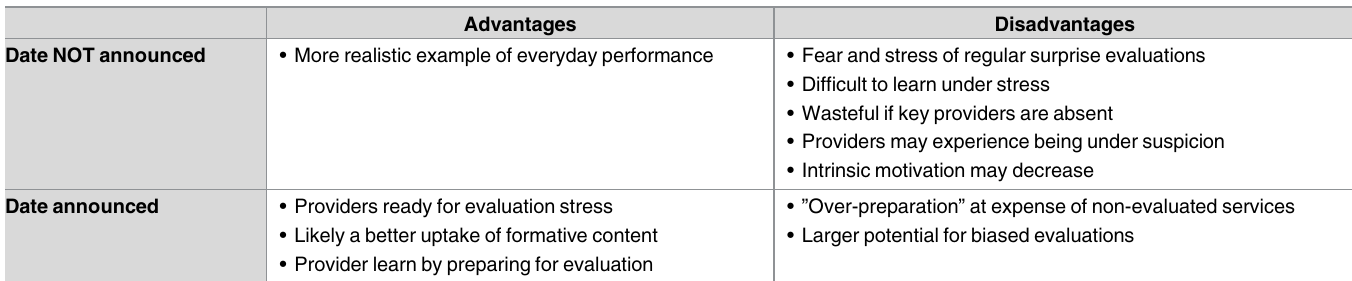
Table 3. Advantages and disadvantages of unannounced